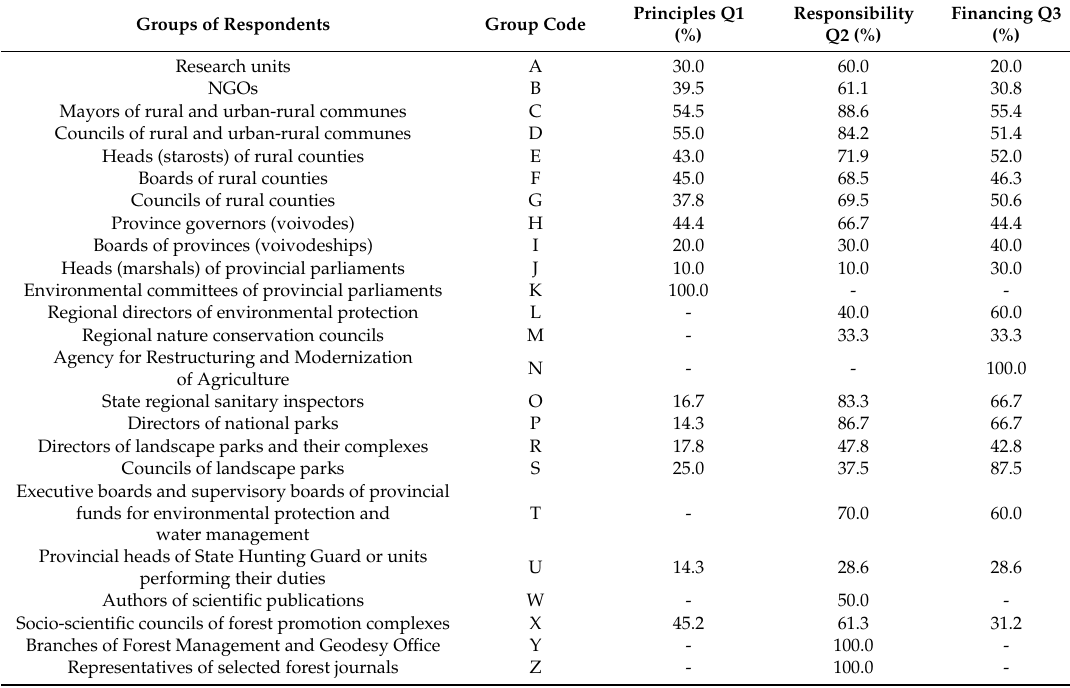
Table 5. Proportions of respondents suggesting that the State Forests should be the only entity responsible for determination of nature conservation’s principles, undertaking responsibility for the nature conservation and responsible for its